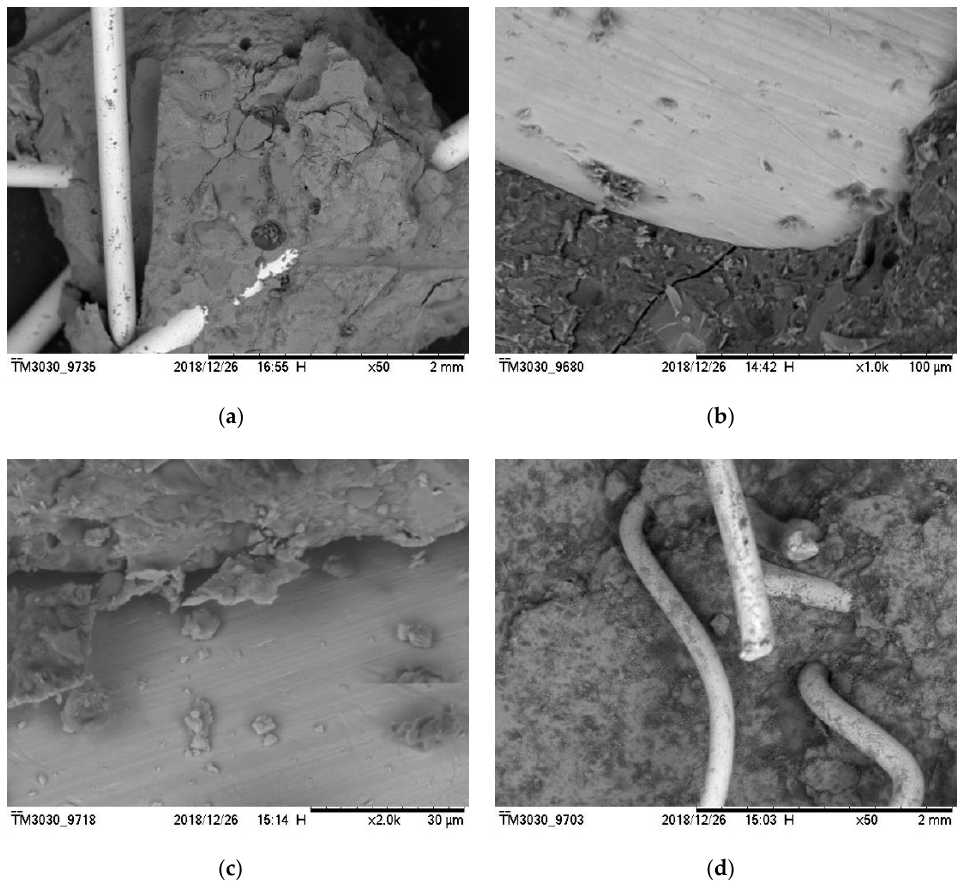
Figure 14 . Micrograph of steel fiber-reinforced active powder concrete: ( a ) Steel fiber distribution; ( b ) steel fibers and tiny cracks; ( c ) steel fibers and hydration products; ( d ) the steel fibers clumped together.